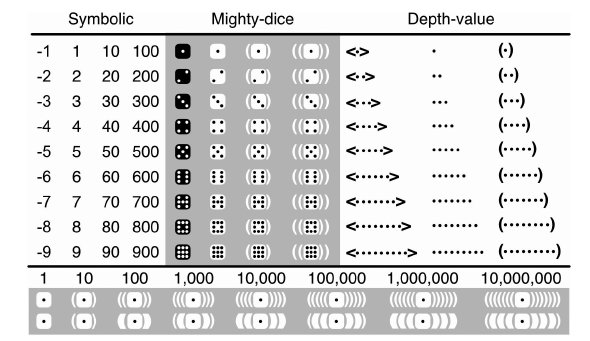
FIGURE 3 | Iconic number representation. Ordinary symbolic numbers are shown along with their iconic translations based on dot tally-marks. Of the mighty-dice translations, all four columns are shown; of the depth-value ones, only the first three. The three rows underneath the main table show symbolic numbers, corresponding iconic numbers, and corresponding iconic numbers that have been adjusted for readability. In the latter, two nested pairs of brackets are replaced by just one pair of thick ones. The might-dice and thin-fat notations, henceforth together referred to as the “black-and-white notation,” have been developed for easy reading; for easy writing of this notation, ideally some kind of an app would be